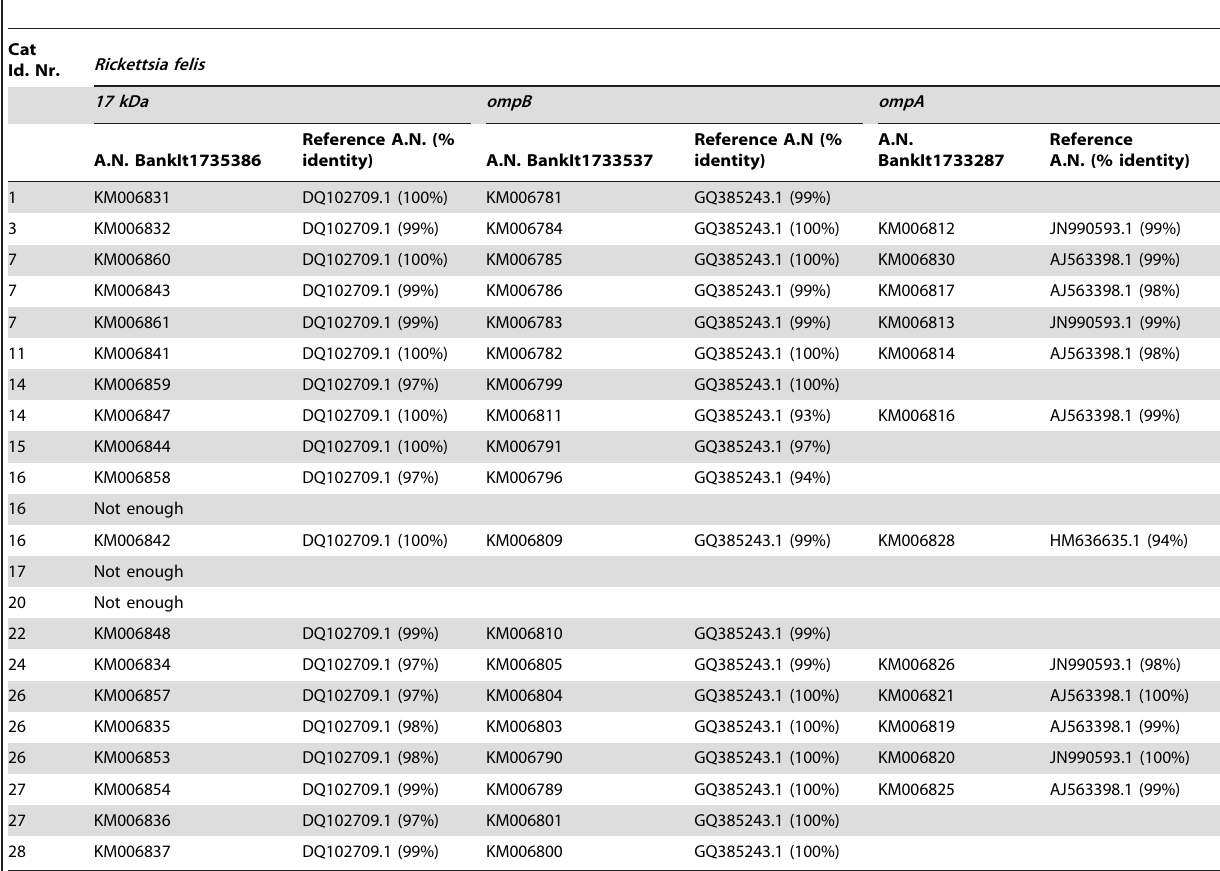
Table 4. Sequencing results for Rickettsia positive fleas C. felis collected from cats.